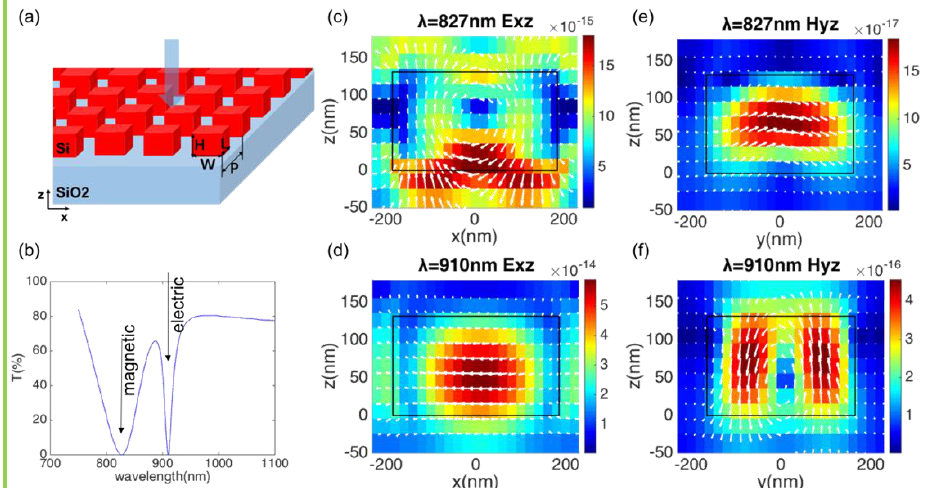
Figure 1. Schematic of meta-atoms and internal electromagnetic excitation. ( a ) Three-dimensional view of meta-atoms, i.e., a nanoblock array on top of the silica substrate. Nanoblocks’ height H = 132nm, width W = 370nm, length L = 330nm, and period P = 460nm. ( b ) Transmittance spectrum of meta-atoms with two dips for magnetic (λ m = 827 nm) and electric (λ e = 910 nm) resonances. ( c , d ) Electric/magnetic field distribution of the magnetic dipole, which is indicated by the vortex-like electric pattern, on two orthogonal cross-sections of the nanoblocks. ( e , f ) Electric/magnetic field distribution of the electric dipole, which is indicated by the vortex-like magnetic pattern, on two orthogonal cross-sections of the nanoblocks. Electric and magnetic field amplitudes are normalized to their maximum values in the study.